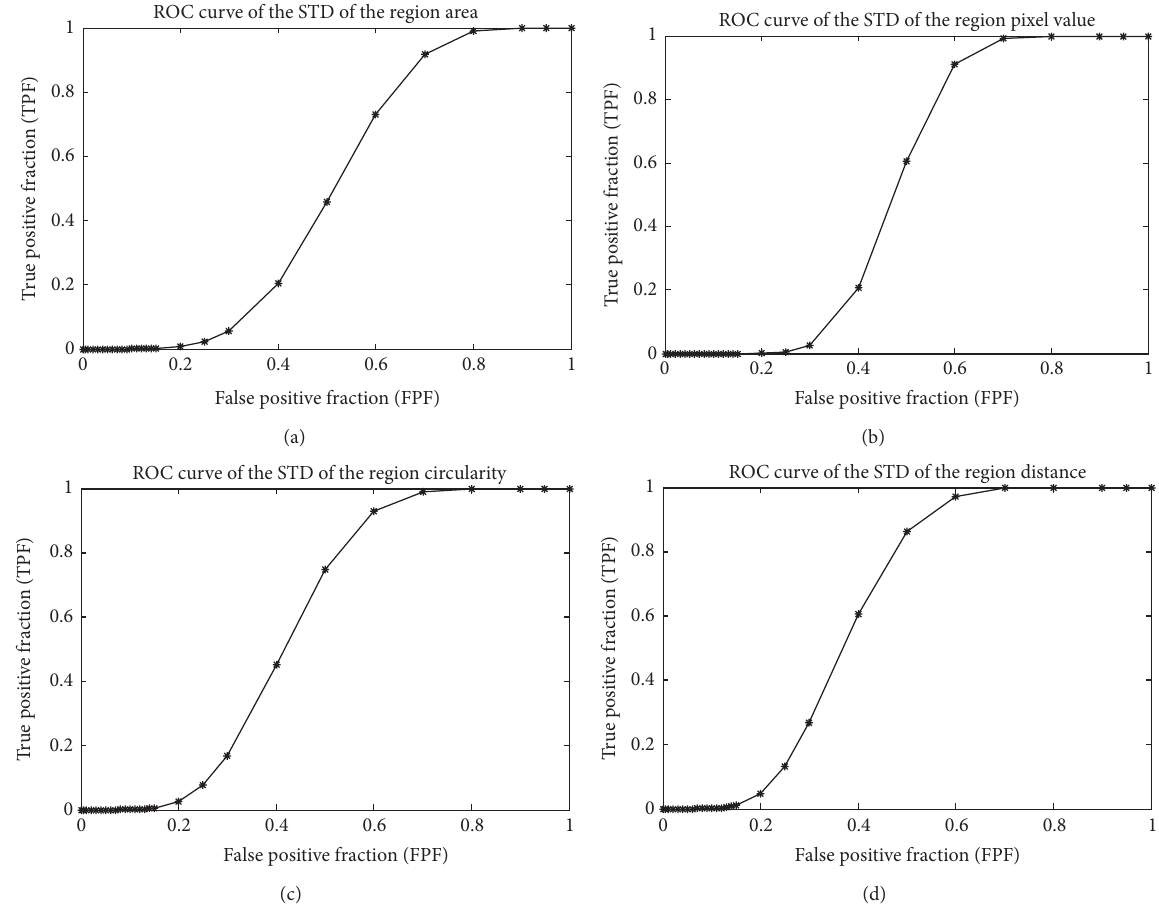
Figure 4: The ROC of the standard deviation of different features including (a) region area, (b) region pixel intensity, (c) region circularity, and (d) region distance. The AUC of the ROC curves is (a) 0.486 ± 0.039 , (b) 0.524 ± 0.039 , (c) 0.581 ± 0.039 , and (d) 0.625 ± 0.038 .